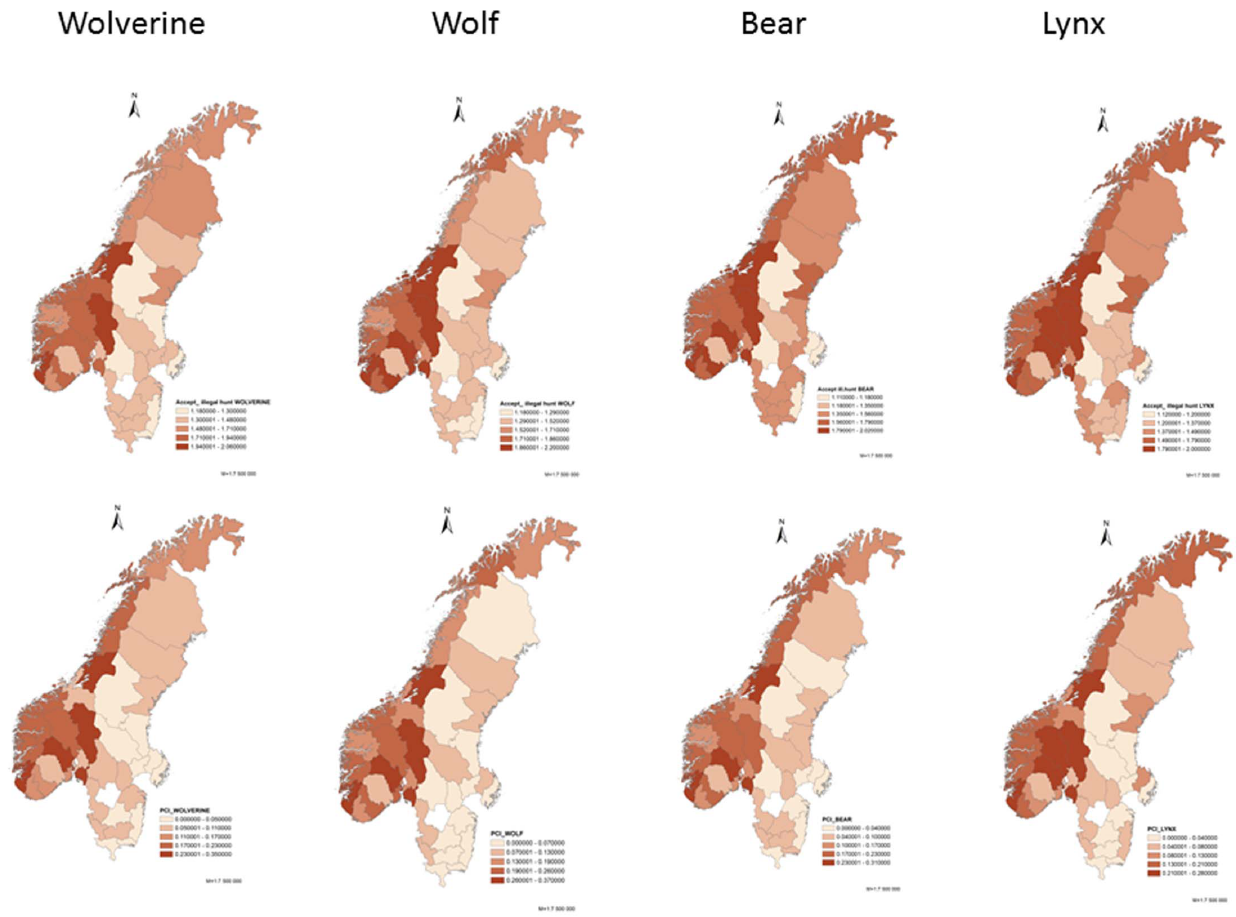
Figure 1. Mapping of mean attitudes towards poaching (upper panel) and mapping of potential conflict index (PCI 2 ) in Scandinavia at the county level (lower panel). Dark colours show high acceptance for poaching in a scale from 1 (highly disagree that illegal hunting is acceptable) to 5 (highly agree that illegal hunting is acceptable), and dark colours at the PCI map show where the potential conflict is highest (highest PCI 2 values). PCI 2 ranges from 0–1.